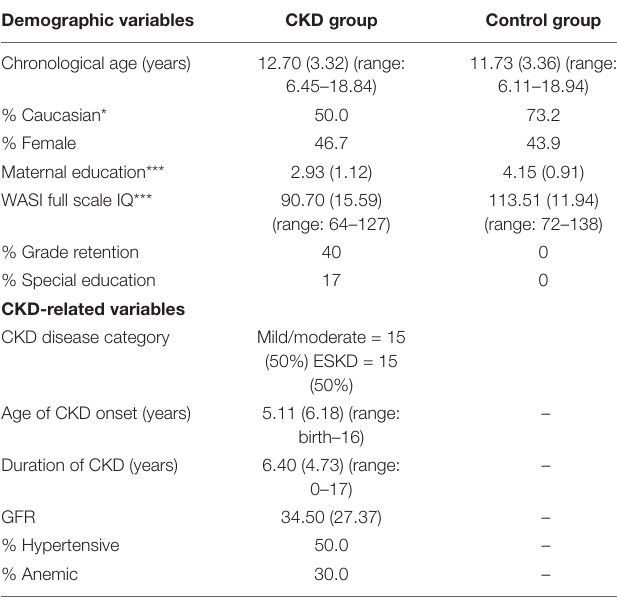
TABLE 1 | Characteristics for the CKD ( n = 30) and Control ( n = 41) groups.